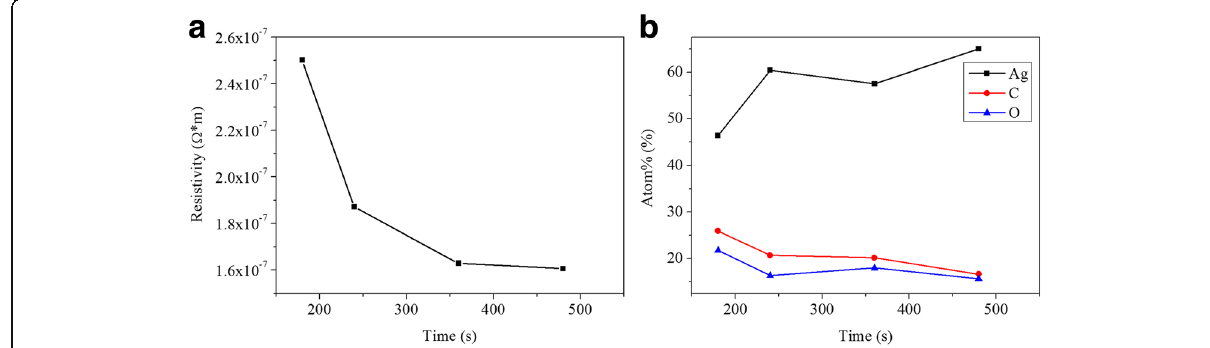
Fig. 2 When D = 37 cm ( a )resistivity versus UV curing time; ( b ) atomic relative content of elements of the films versus UV curing